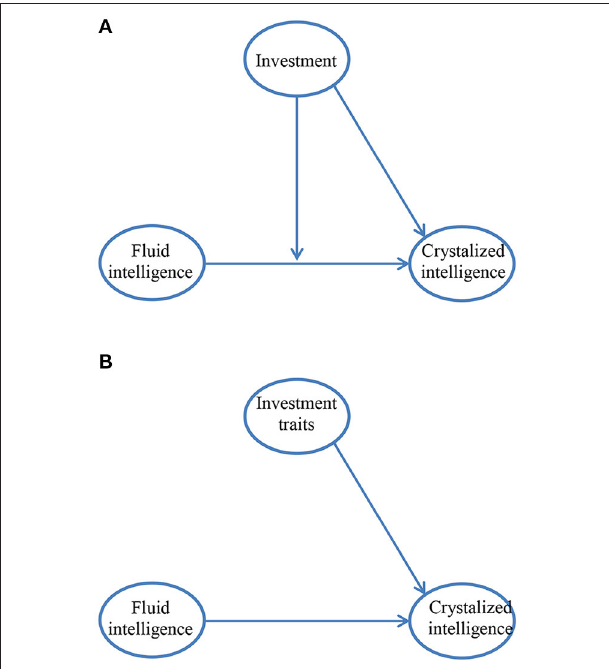
FIGURE 1 | (A) An interaction model of the relationship between fluid and crystalized intelligence. (B) An additive model of the relationship between fluid and crystalized